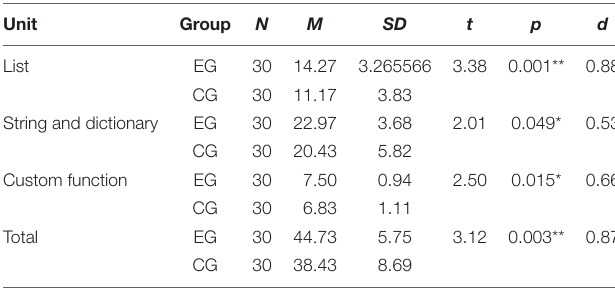
comprehension in the unit tests of the two groups.